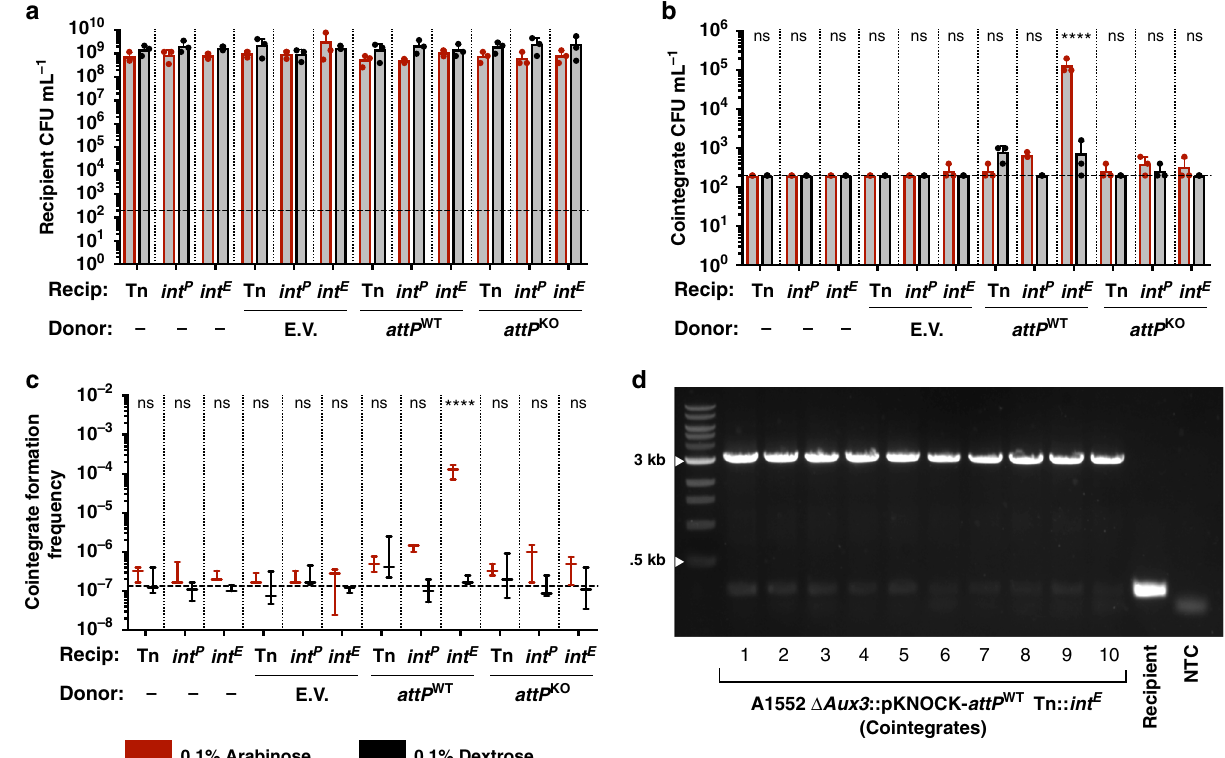
Fig. 5 The Aux3 E integrase catalyses integration of circular Aux3 into the naïve attB_Aux3 site. a Quanti fi cation of viable counts of total recipient V. cholerae cells (Rif R /Gent R ) from conjugative transfer experiments. b Quanti fi cation of viable counts of cointegrate V. cholerae cells (Rif R /Gent R /Kan R ) from conjugative transfer experiments. c Cointegrate formation frequency from transfer experiments as determined by cointegrate counts divided by total recipient counts. d PCR veri fi cation of pKNOCK- attP WT integration at the de fi ned Aux3 locus with primers P1 and P4 (Fig. 4a). White arrows indicate ladder band sizes. Gel is representative of three distinct experiments ( n = 3). a – c Arabinose-induced experiments are shown in red and dextrose control experiments are shown in black. Horizontal dashed line indicates the limit of detection. Quantitative results are from three distinct experiments ( n = 3). Horizontal bars represent the mean and error bars indicate ±SD. Signi fi cance was determined by a two-way ANOVA with Sidak ’ s multiple comparisons test (ns non-signi fi cant, **** p < 0.0001). E.V. = S17 λ pir;pKNOCK-Kan; attP WT = S17 λ pir;pKNOCK- attP WT ; attP KO = S17 λ pir;pKNOCK- attP KO ; Tn = A1552